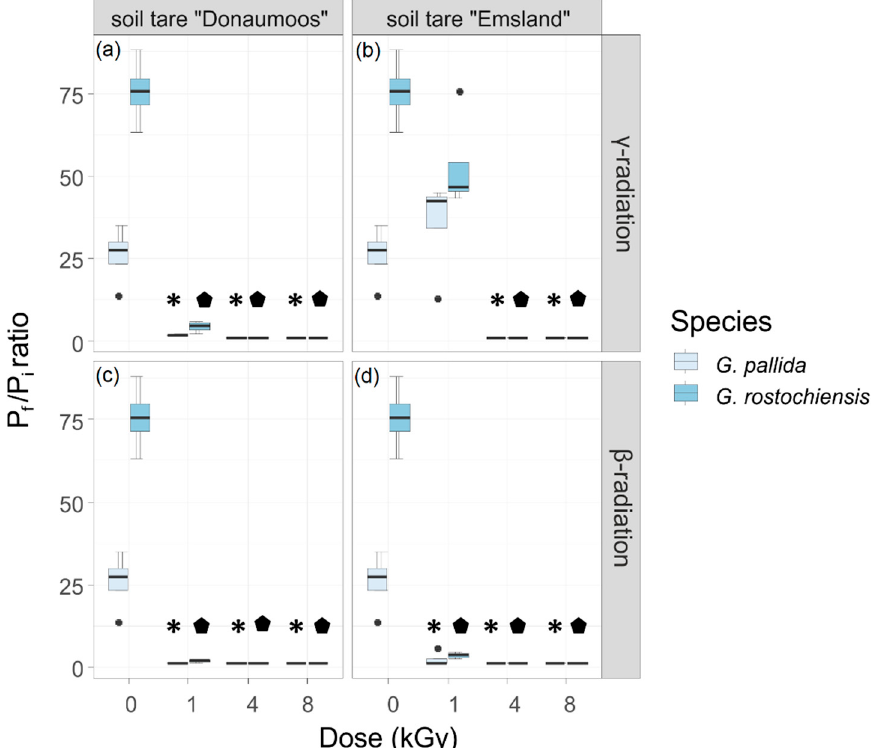
Figure 4. Cyst formation rates for G. pallida and G. rostochiensis from irradiated soil tares. The ratio of newly formed cysts, P f (final population) and the number of (P i ) initial cysts (50) added to the susceptible potato cultivar “Desireé”, at the time of harvest, 15 weeks after potato planting. P i cysts were either 0, 1, 4, or 8 kGy γ ( a , b ) or β ( c , d ) irradiated. Globodera pallida and G. rostochiensis . During irradiation, the cysts were placed in soil tare “Emsland” ( b , d ) or soil tare “Donaumoos” ( a , c ). Data were analysed by the non-parametric Kruskal–Wallis test with a pairwise Wilcoxon post hoc test using adjusted p -values. Box–whisker plots display the median values of four replicates. Asterisks indicate the significant differences to the respective non-treated G. pallida and pentagons to the respective non-treated G. rostochiensis controls.